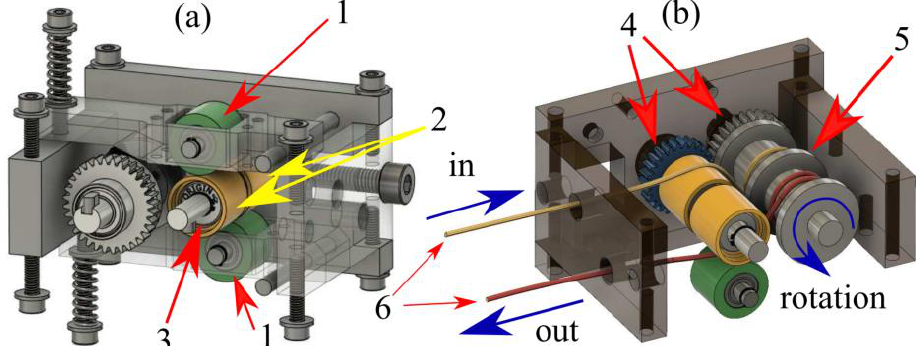
Figure 2. Cable winder with non-back-drivable mechanism: ( a ) partial front and ( b ) back views. 1: idler rollers; 2: feeder rollers; 3: one-way clutch; 4: spur gears; 5: spool; 6: tendons.